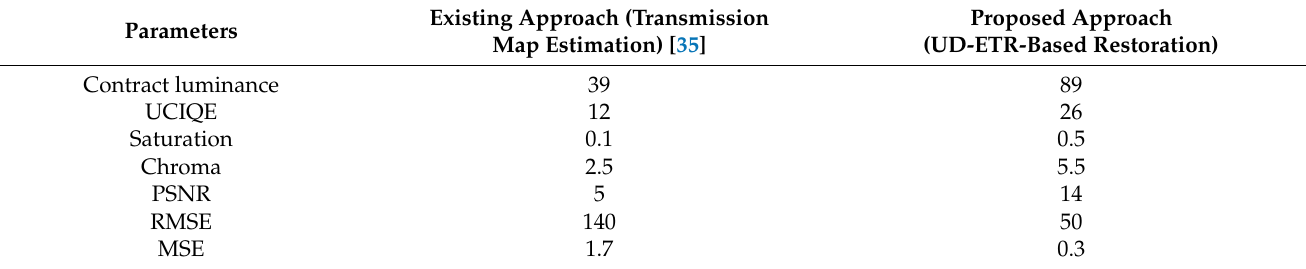
Table 3. Comparison of the parameters from transmission map estimation and